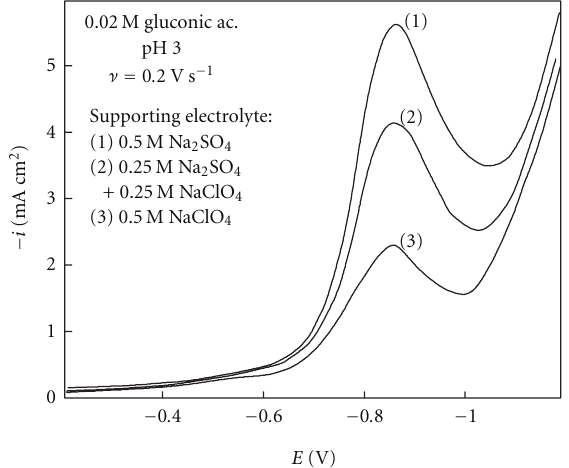
Figure 3: Comparison of voltammetric data obtained at ν = 0 . 2Vs − 1 for 0.02 M gluconic acid solutions containing di ff erent supporting electrolytes as